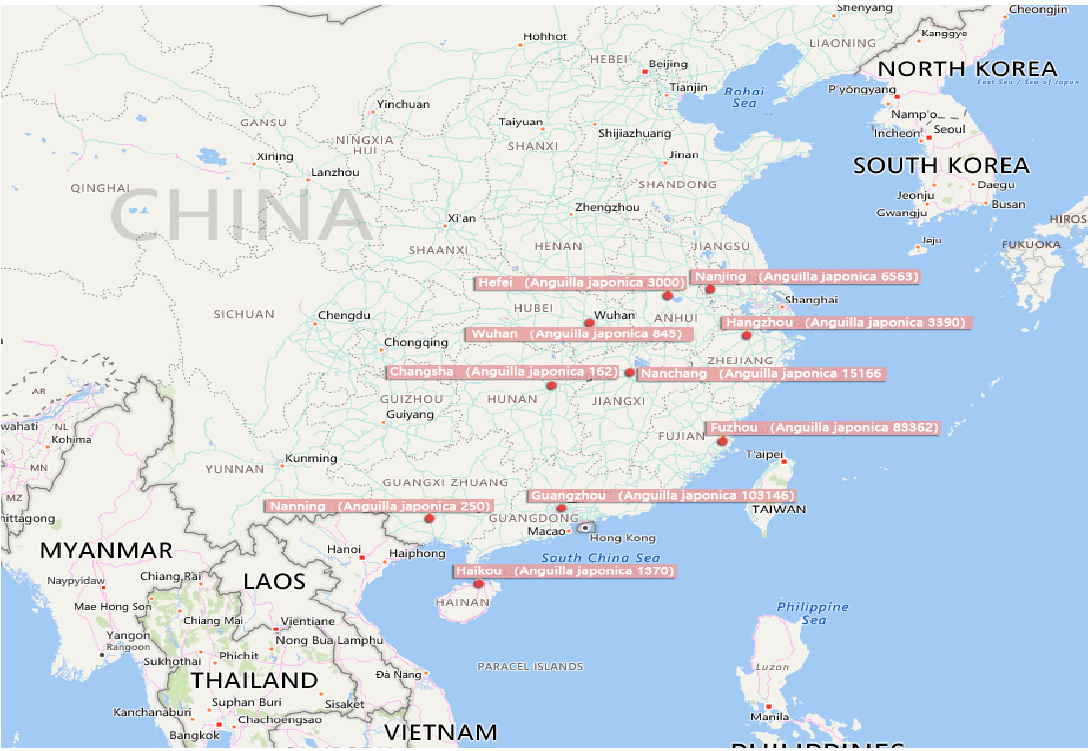
Figure 2. Distribution map of eel production in China (the output of eel culture in various provinces is taken from the 2018 China Fishery Statistics Yearbook [19], and the unit omitted after the number on the way is ton.